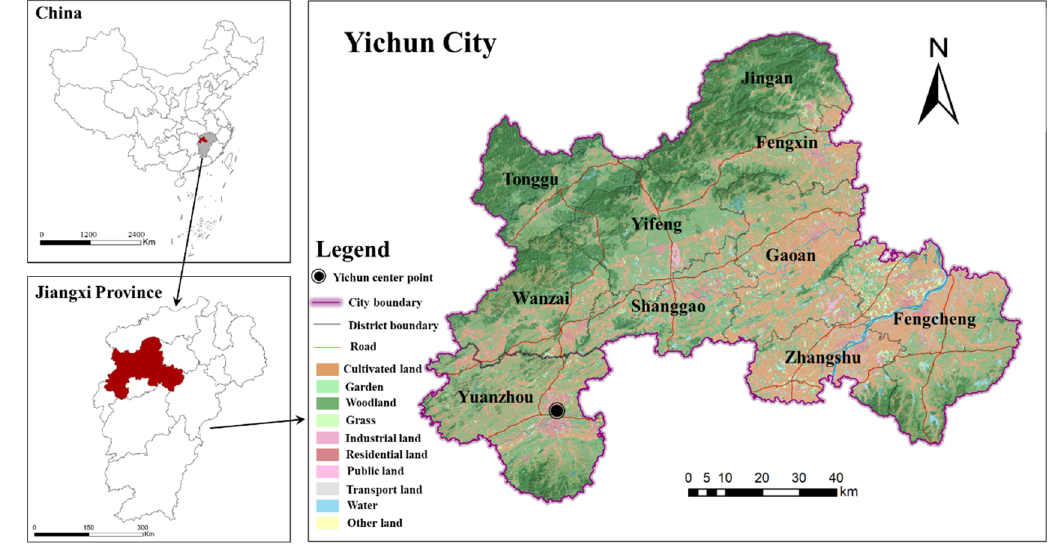
Figure 1. Study area.